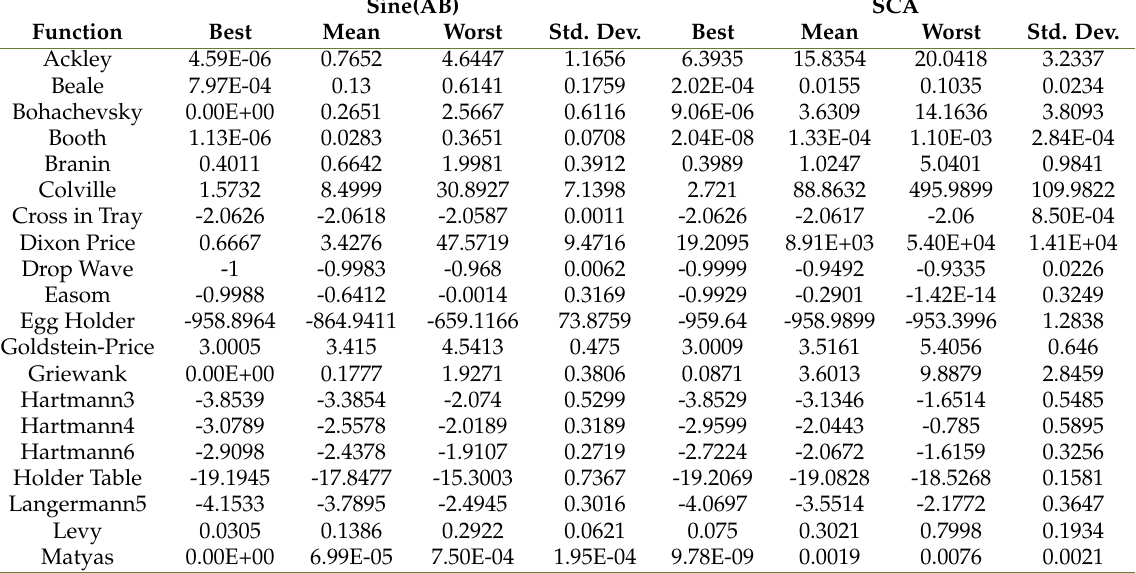
Table 2. Results of a = 1.5 (3 for SCA)